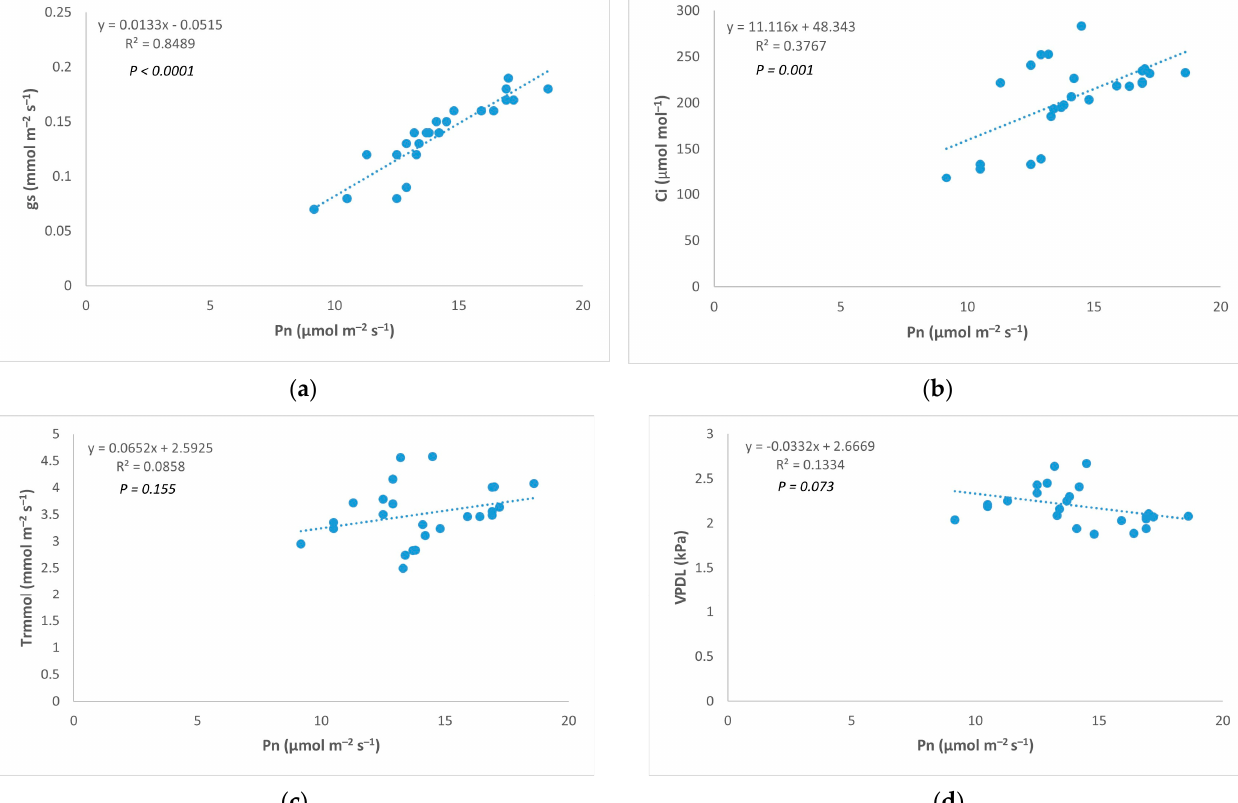
Table 4. Photosynthetic activities of plants receiving five N rates in 2021. 3.5. Tanshinone I, Tanshinone IIA, Cryptotanshinone, and Salvianolic Acid B